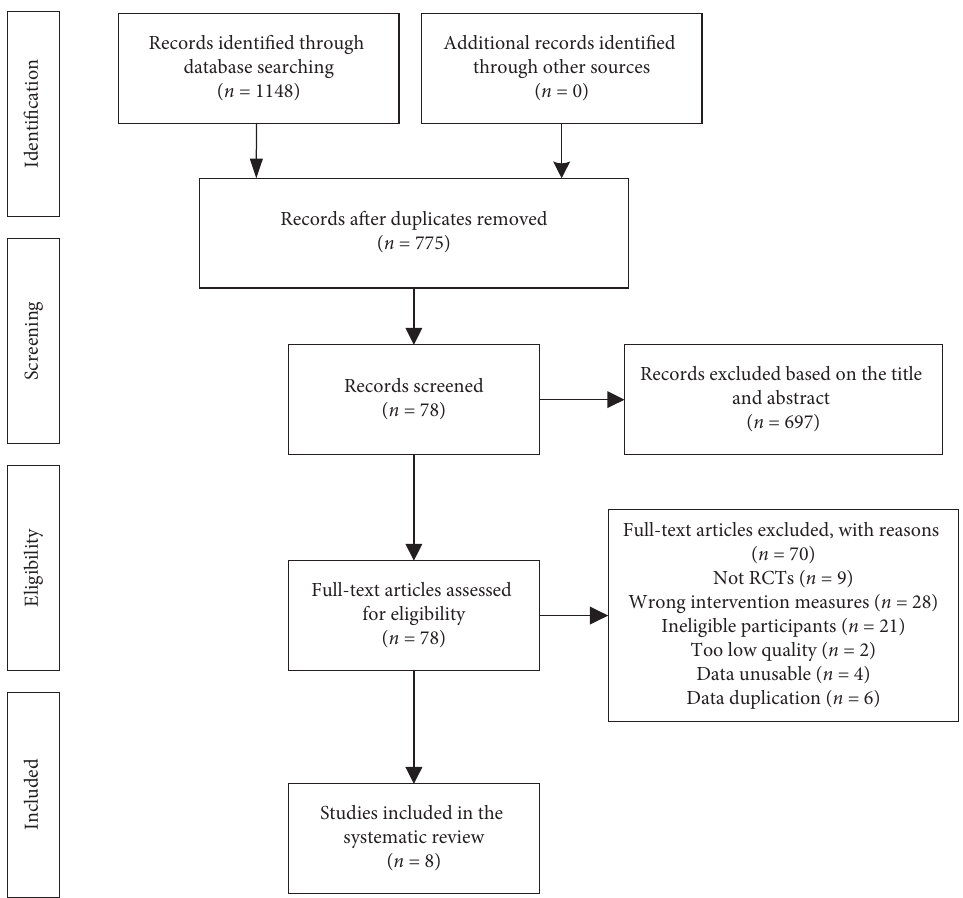
Figure 1: Flow diagram of the